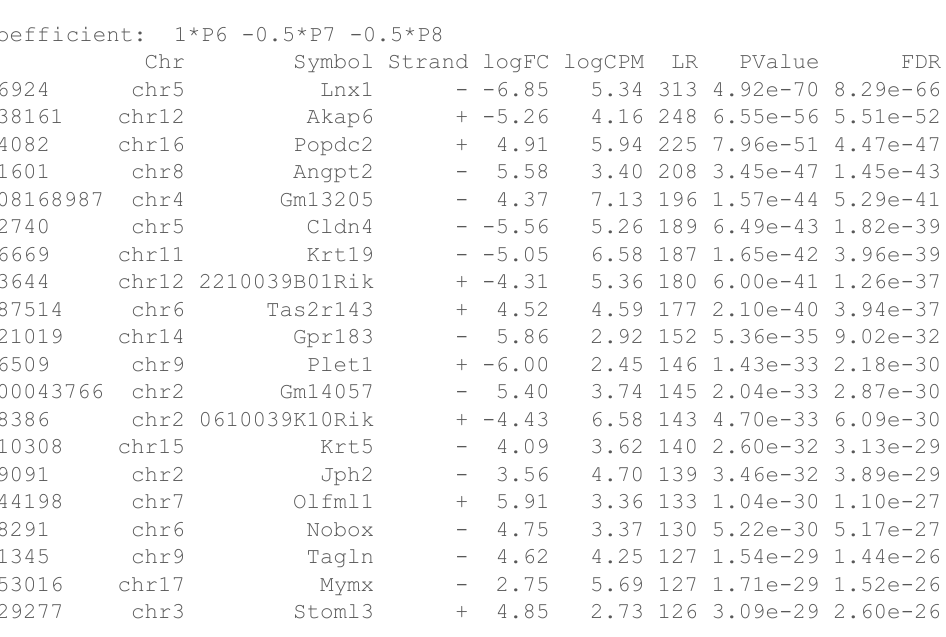
The top set of most differentially methylated gene promoters can be viewed with topTags : > topTags(lrtpr, n=20)